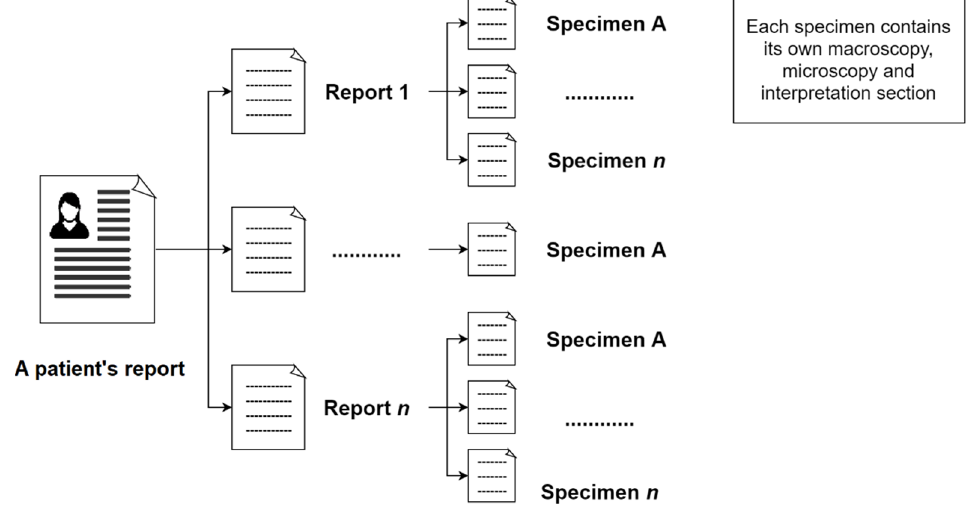
Figure 1. Representation of pathology report’s composition.